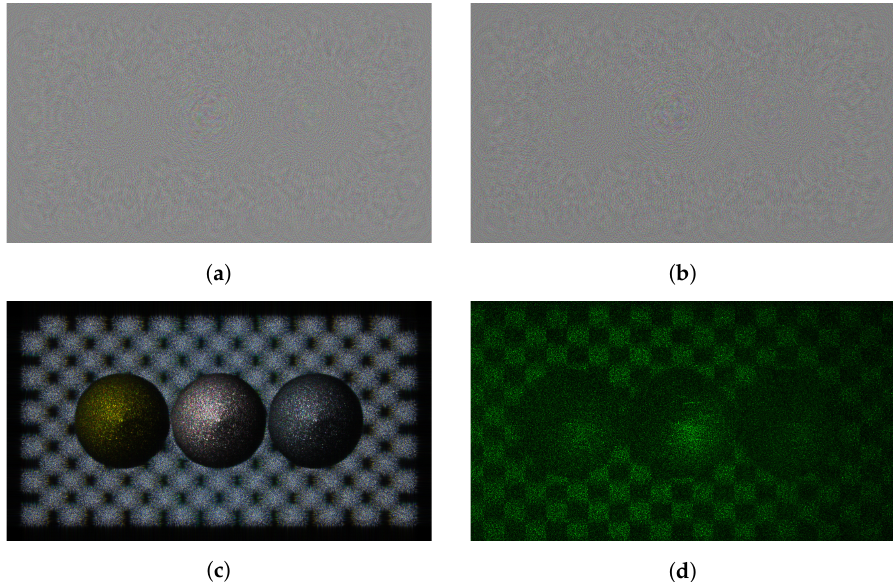
Figure 6. Sphere3 hologram provided by JPEG pleno ( a ) real and ( b ) imaginary hologram, ( c ) ampli- tude of the reconstruction hologram, ( d ) optical reconstruction.